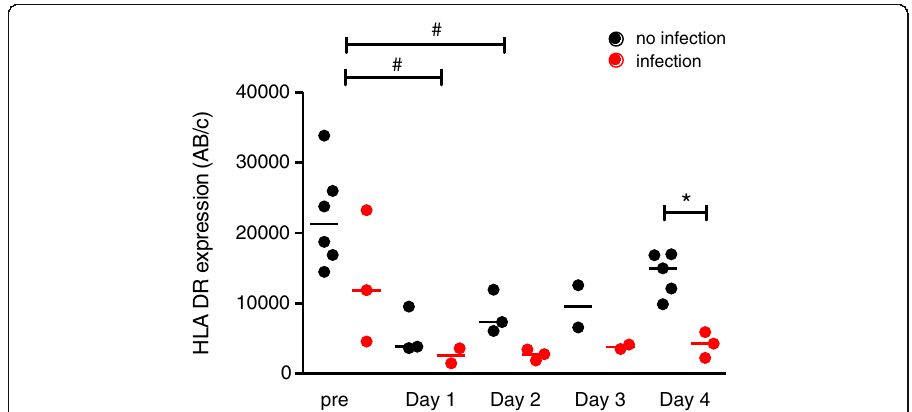
Fig. 1 HLA-DR expression in neonates after cardiopulmonary bypass. Each point in red represents expression of HLA-DR in patients who displayed an episode of NI. The Kruskal – Wallis test was used for comparisons of multiple groups, with Dunn ’ s multiple comparisons test for intergroup comparisons (preoperatively, 1, 2, 3 and 4 days after CPB) (# p <0.05). The Mann – Whitney test was used to compare infected versus non-infected patients on day 4 (* p